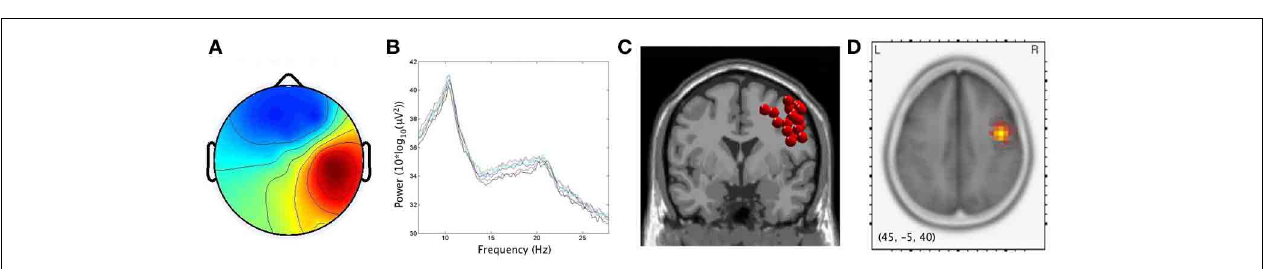
FIGURE 3 | Cluster results for left µ component. (A) mean scalp potential distribution (W − 1 ) scaled to RMS microvolts, (B) mean spectra of the components within the cluster for each condition, (C) distribution of